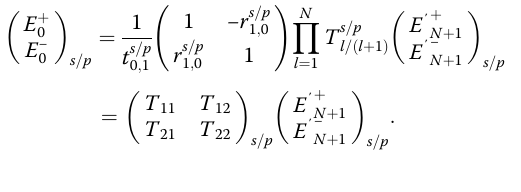
IR Dielectric Function Model